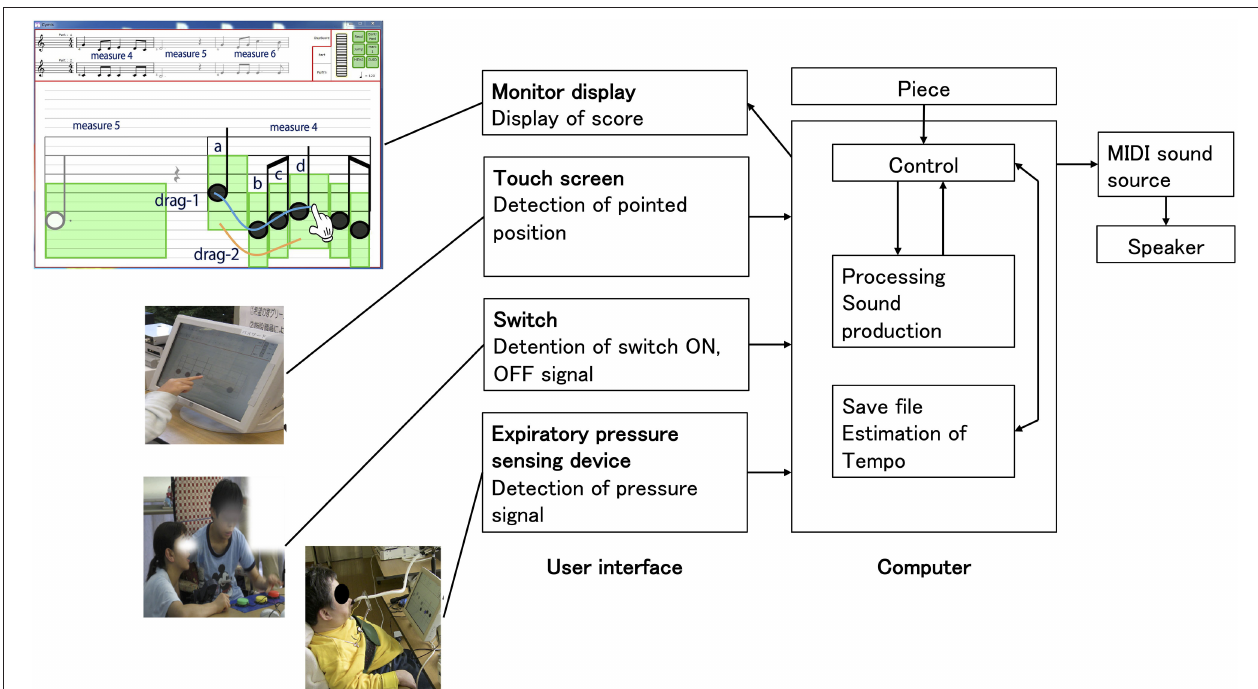
FIGURE 2 | For the musical instrumental performance, we used an accessible digital musical instrument called the Cymis (cyber musical instrument with score) [Akazawa et al. ( 21)], which has a built-in programmed score and is played using touch panels and switches. The technical novelty of the Cymis lies in its human interface devices that emphasize the sensory experience and is characterized by its built-in score information and program. This computerized musical instrument system comprises a monitor display, a personal computer, a sound source, a speaker, and human interface devices (image sensor for finger movement detection, touch panel, and others). The system is an electronic musical instrument that is barrier-free, allows understanding of music notation, and allows beginners of any age to easily play music comprising melody, rhythm, and